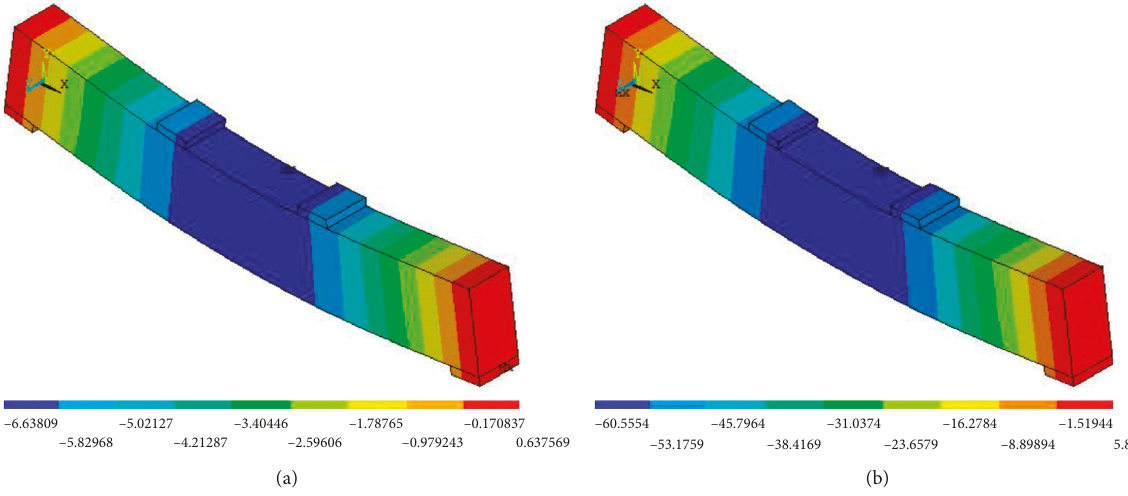
Figure 9: 3D views of deflections in the B1 model at (a) the yield load stage and (b) the maximum load stage.